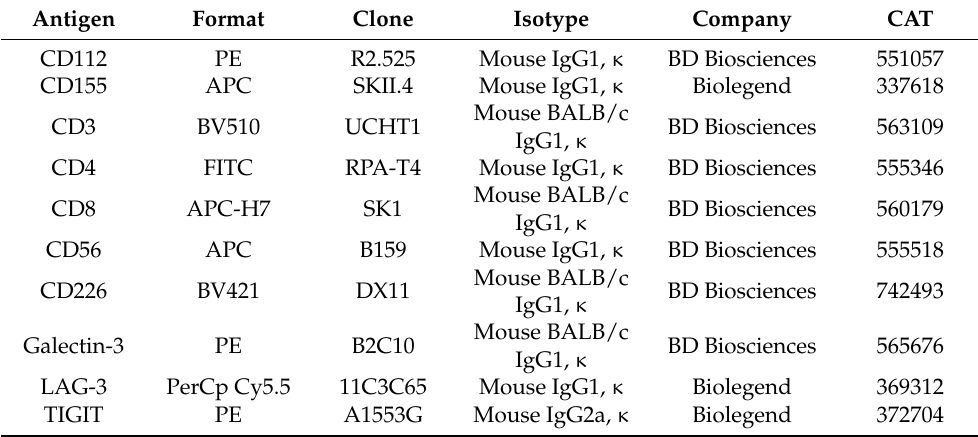
Table 2. Fluorochrome-conjugated monoclonal antibodies used in the